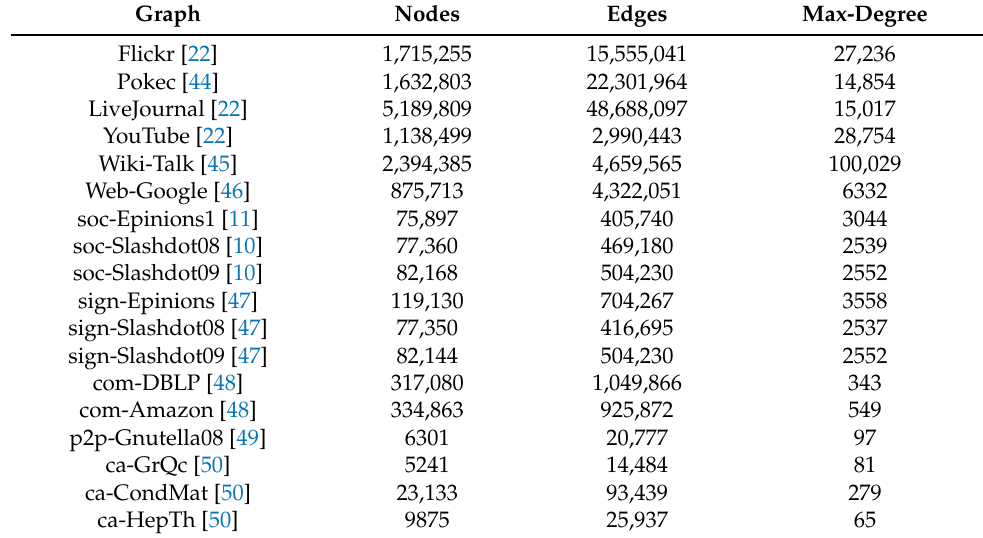
Table 2. Graph datasets used in our experiments. “edges” refers to the quantity of edges in the undirected graph generated by discarding edge labels. “max-degree” denotes the maximum quantity of edges for a node in an undirected graph. Graph Nodes